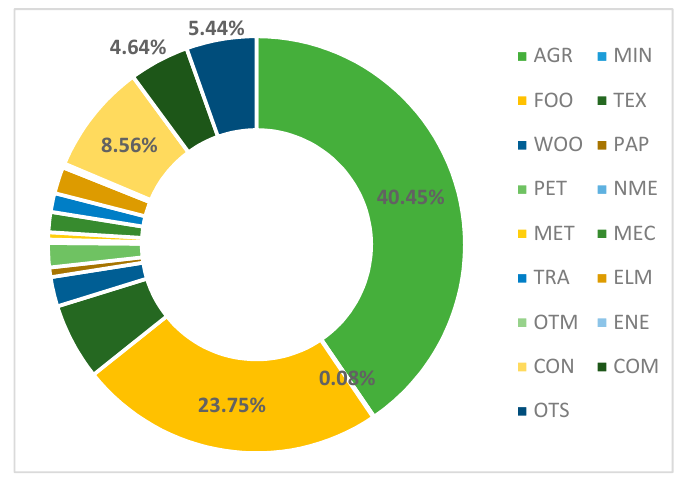
Figure 2. Complete agricultural land footprints by sectors.